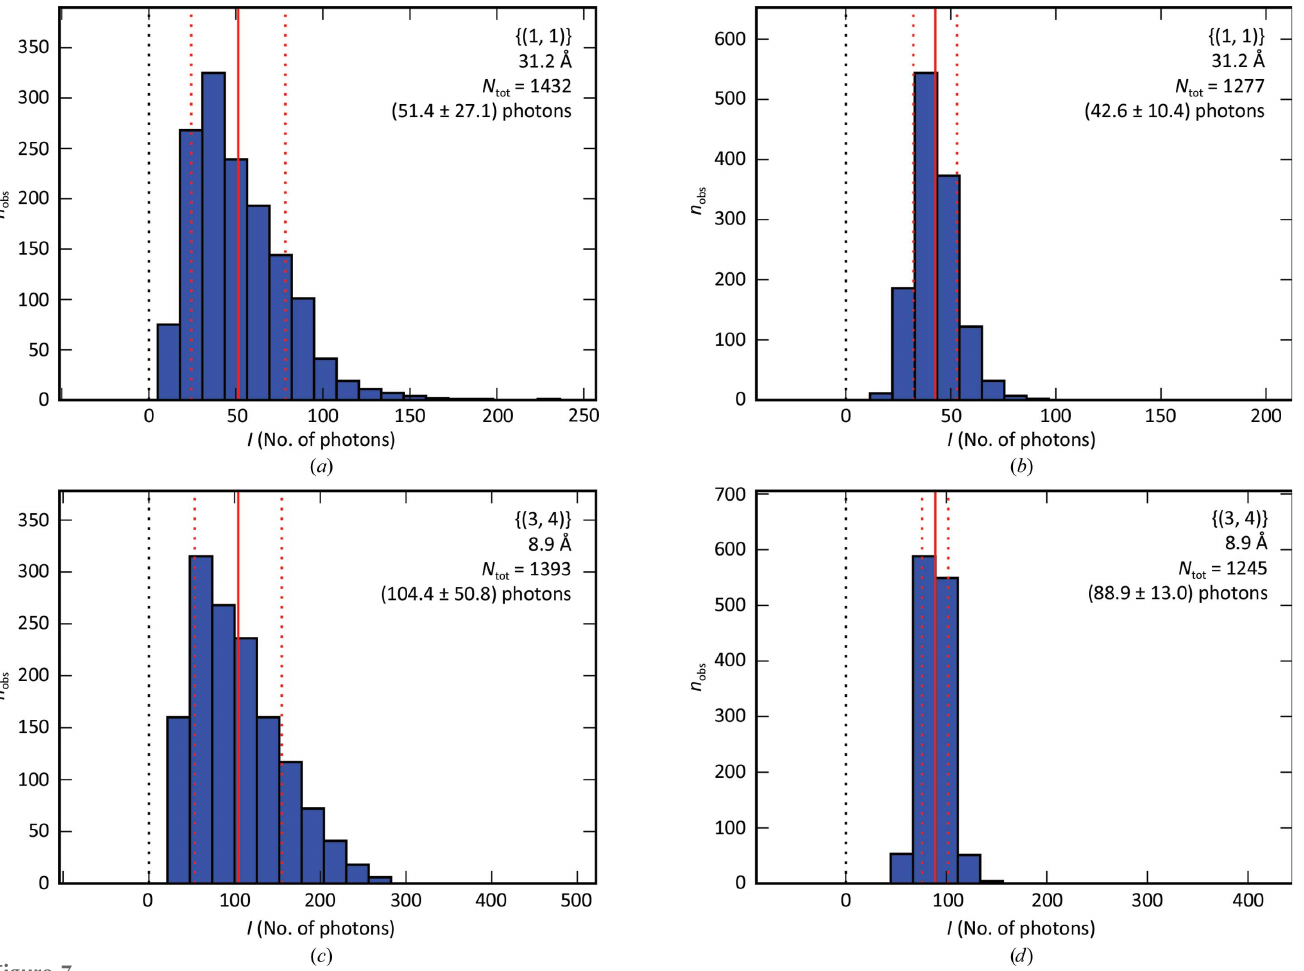
Figure 7 Merged peak intensities. Histograms of the peak intensities of the p 3 reflections {(1, 1)} ( a , b ) and {(3, 4)} ( c , d ) obtained in step 2 of the data-analysis procedure before rescaling (left column) and after rescaling (right column). The red vertical line represents the average number of photons, and the two dotted red vertical lines delimit the interval within the standard deviation. The in-plane resolution, number of observations, intensity average and intensity standard deviation are